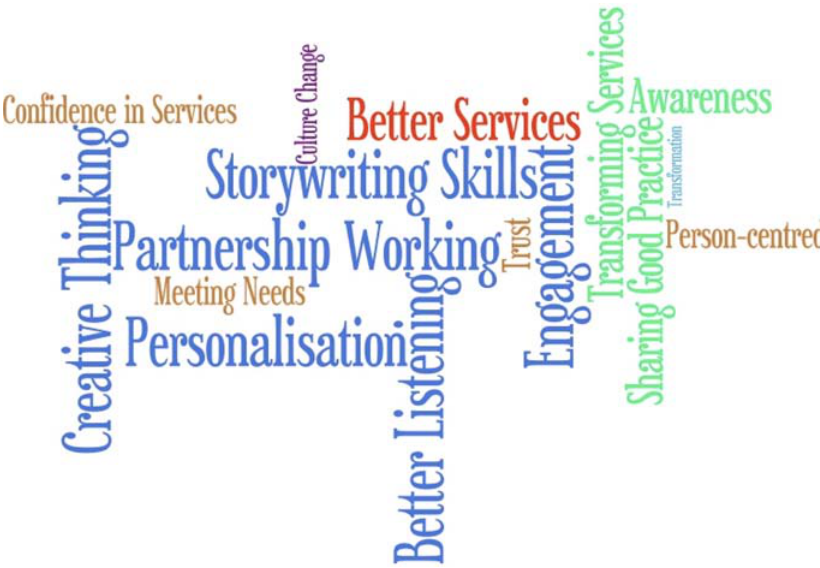
Figure 1. A wordle-analysis of the outcomes from the Social Care Co.